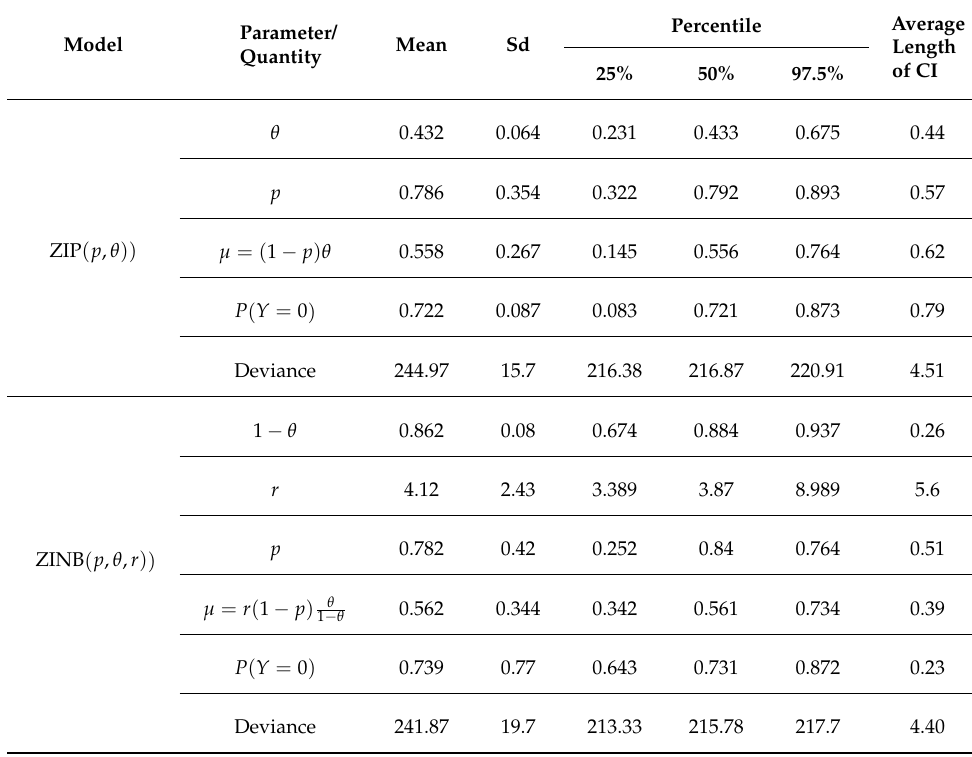
Table 3. Posterior summary (without covariates): zero inflated